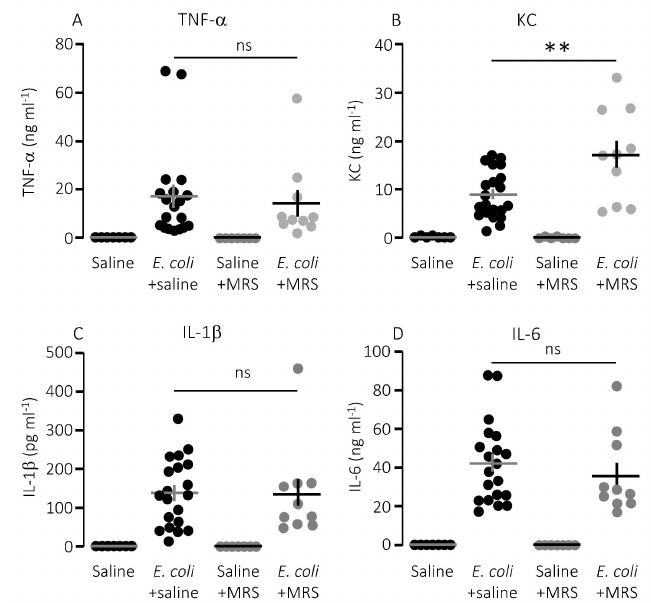
Figure 3. P2Y 1 receptor antagonist MRS2500 (MRS) increase the proinflammatory cytokine keratinocyte chemoattractant in mice exposed to sepsis with E. coli . The level of the following proinflammatory cytokines were measured in plasma from mice exposed to saline or MRS2500 infusion (25.9 µ g / h) in the absence or presence of 30 × 10 6 E. coli iv: ( A ) TNF- α ; ( B ) keratinocyte chemoattractant (KC); ( C ) IL-1 β ; and ( D ) IL-6. MRS2500 n = 7, E. coli + MRS2500 (25.9 µ g / h) n = 10), ** p <